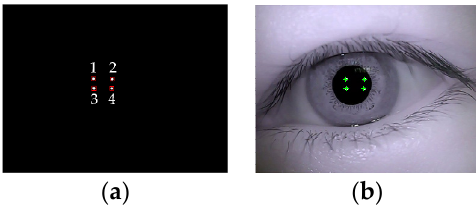
Figure 6. Glint detection: ( a ) rough location of glint; ( b ) glint detection results. As a sample, some of the pupil and glint centers detected are shown in Table